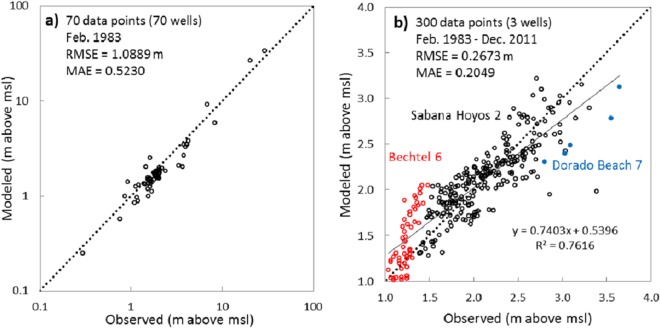
Scatter calibration diagrams of simulated versus observed hydraulic heads.(a) Steady-state calibration of the flow model (70 monitoring wells); and (b) Transient calibration of the flow model over three decades (3 monitoring wells).